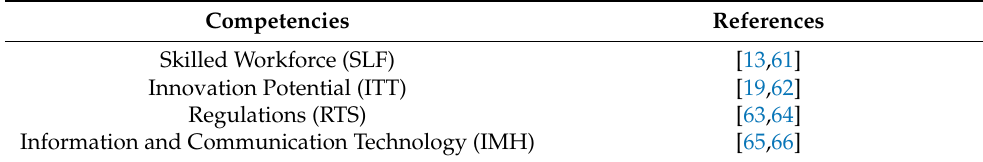
Table 2. Selected knowledge-oriented competencies for emerging